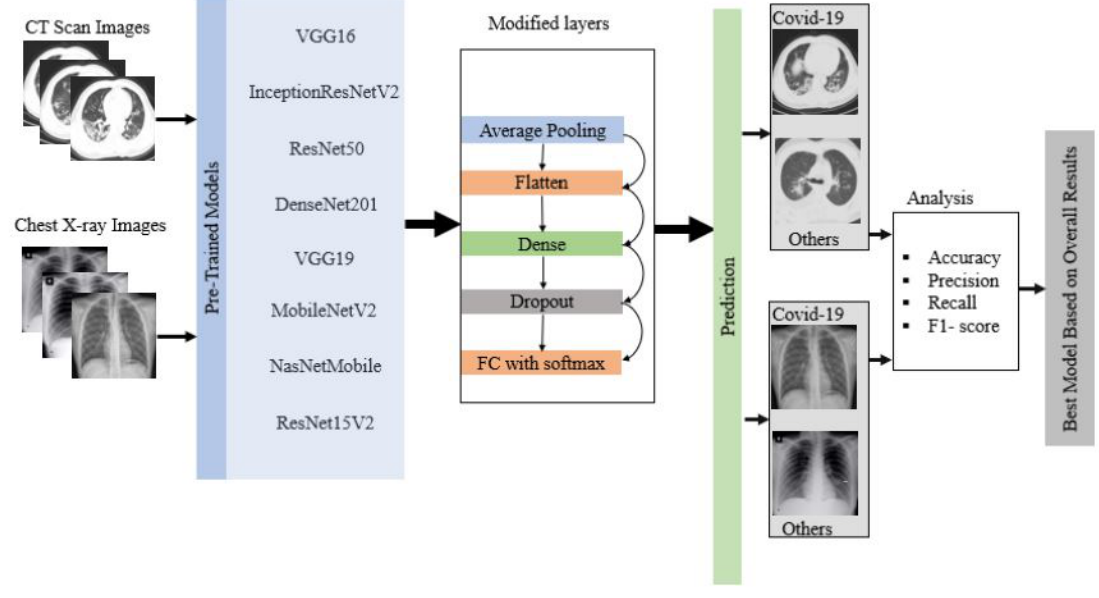
Figure 3. Flow diagram of the overall